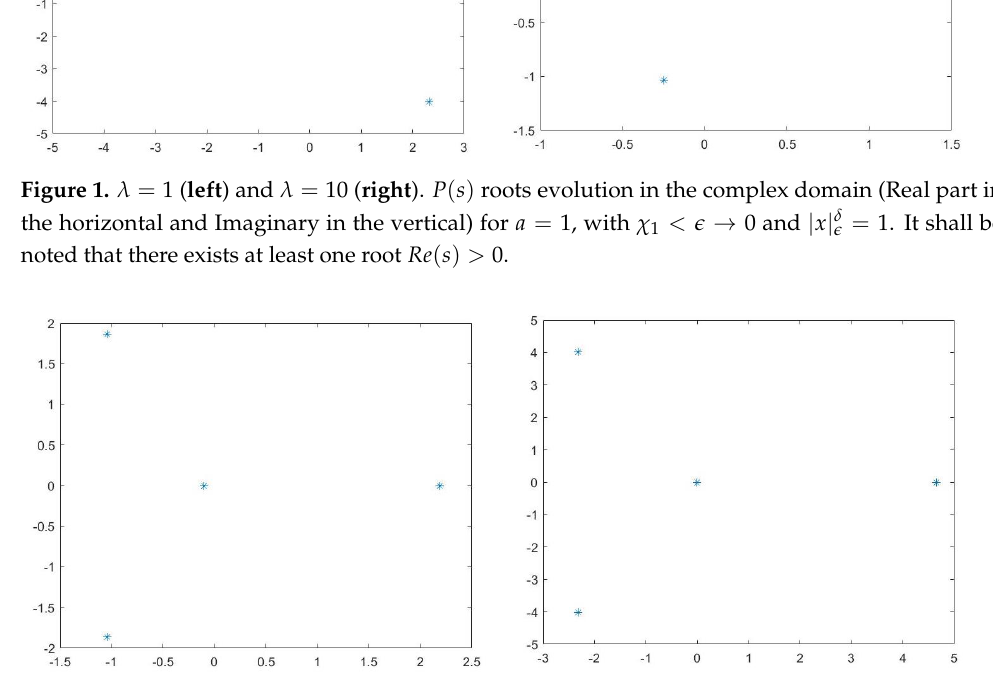
Figure 2. Root evolution for λ = 100 ( left ) and λ = 1000 ( right ). To this end, a = 1, with χ 1 < (cid:101) → 0 and | x | δ (cid:101) = 1. It shall be noted that there exists at least one root Re ( s ) > 0.